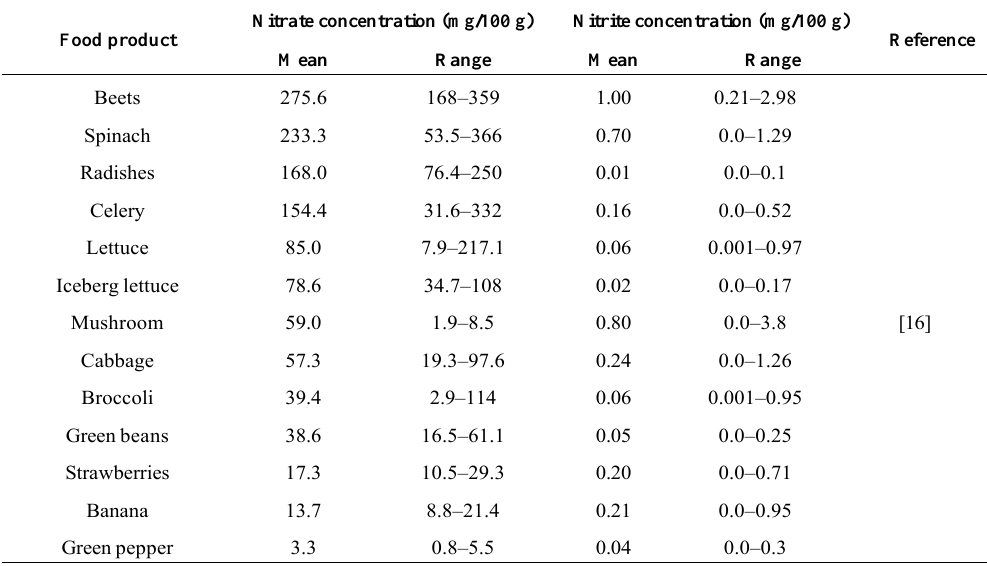
Table 1. Nitrate and nitrite contents of food